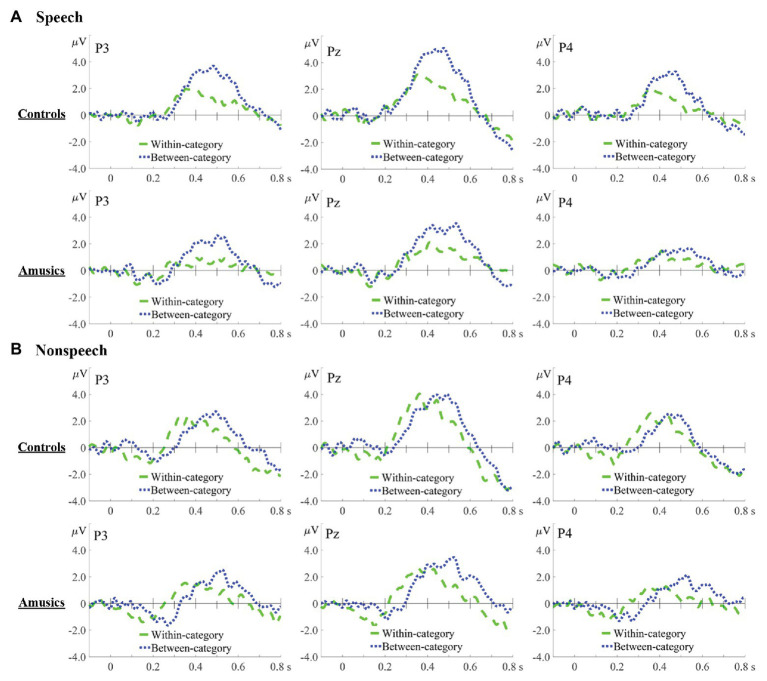
Difference waves in speech (A) and nonspeech (B) contexts for within-category deviants minus standards (green dashed lines) and between-category deviants minus standards (blue dotted lines) in the controls and amusics, which are displayed at three representative electrodes: P3 (left), Pz (middle), and P4 (right).